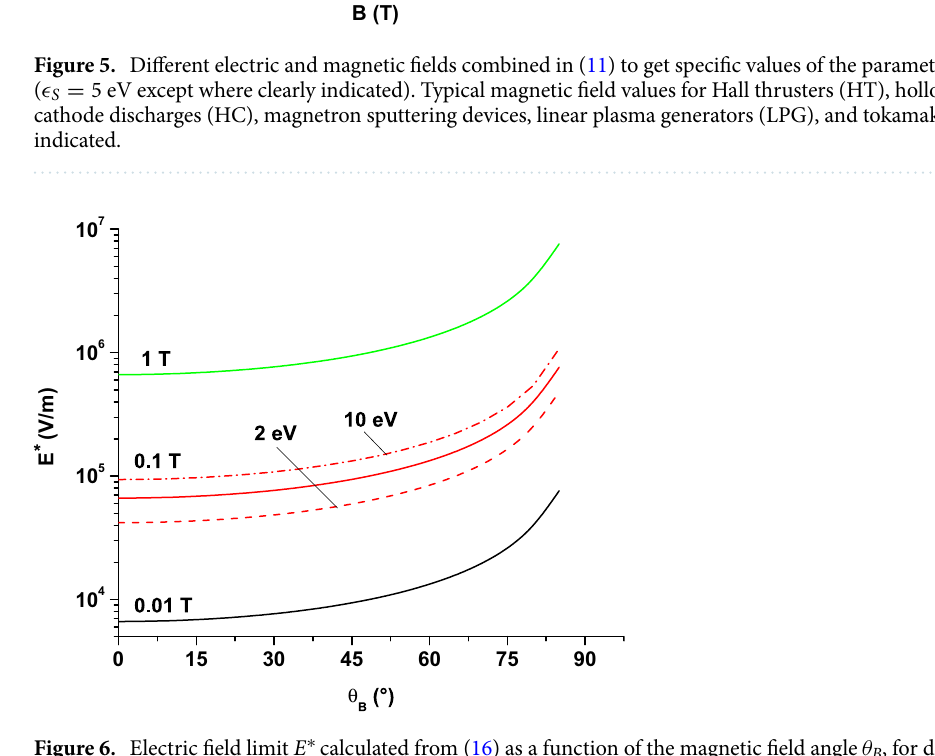
Figure 6. Electric field limit E ∗ calculated from (16) as a function of the magnetic field angle θ B , for different 5 eV except where clearly magnetic flux densities ( ǫ S =